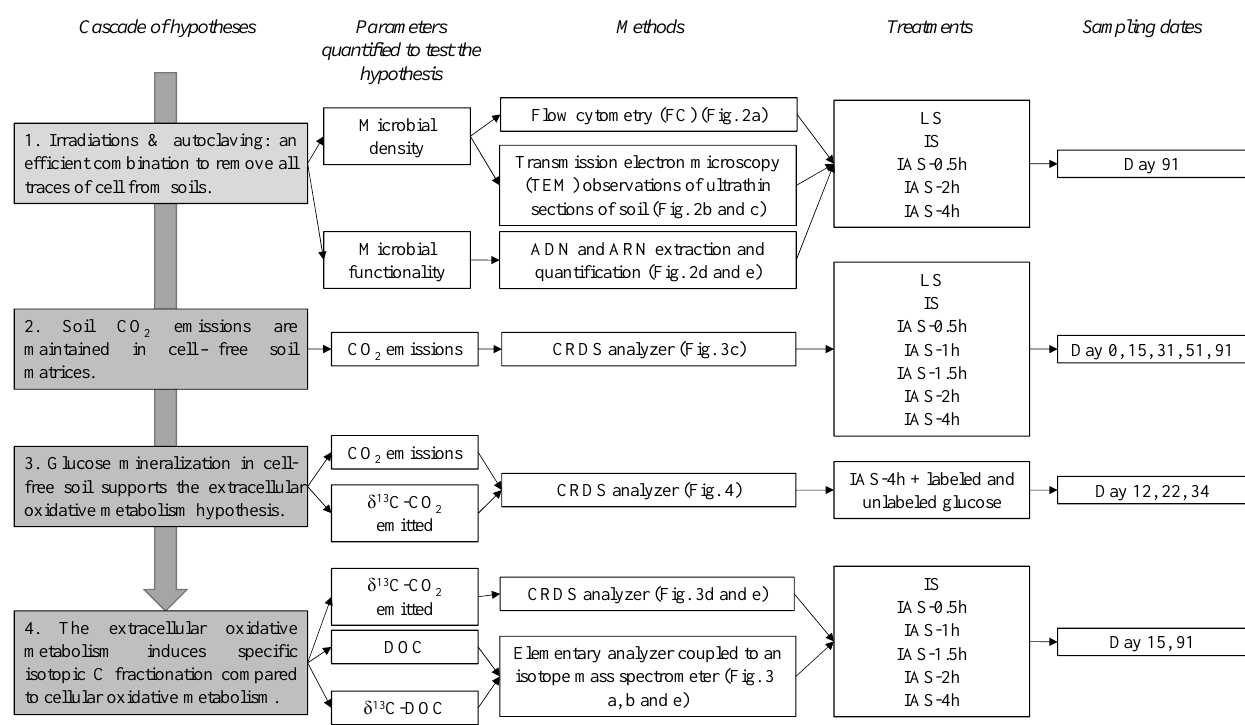
Figure 1. General experimental design of the study, including our hypotheses, parameters, methods, and the samples ( n = 3 for each date and treatment studied) used to test these